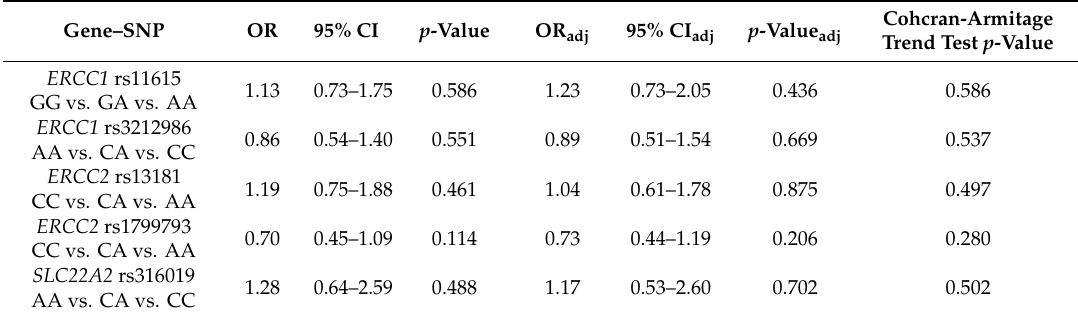
Table 6. Odds ratio of minor allele addition in adjusted-AKI outcome (N = 163) and Cohcran-Armitage trend test result for additive model